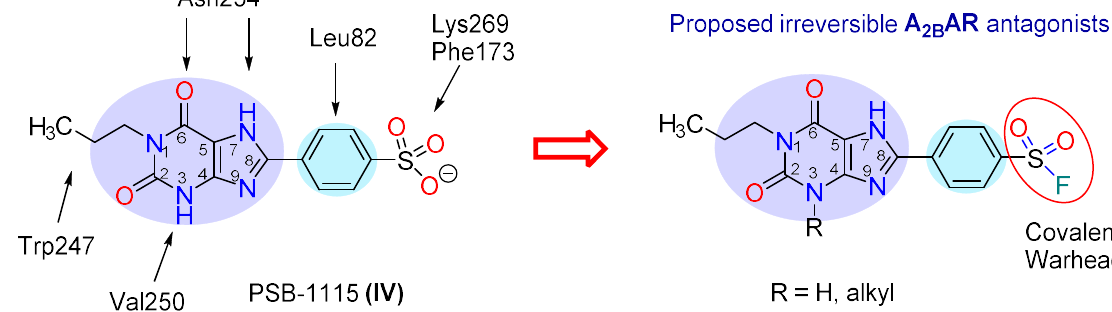
Figure 2. Design of irreversible A 2B AR antagonists based on a published docking pose [18].